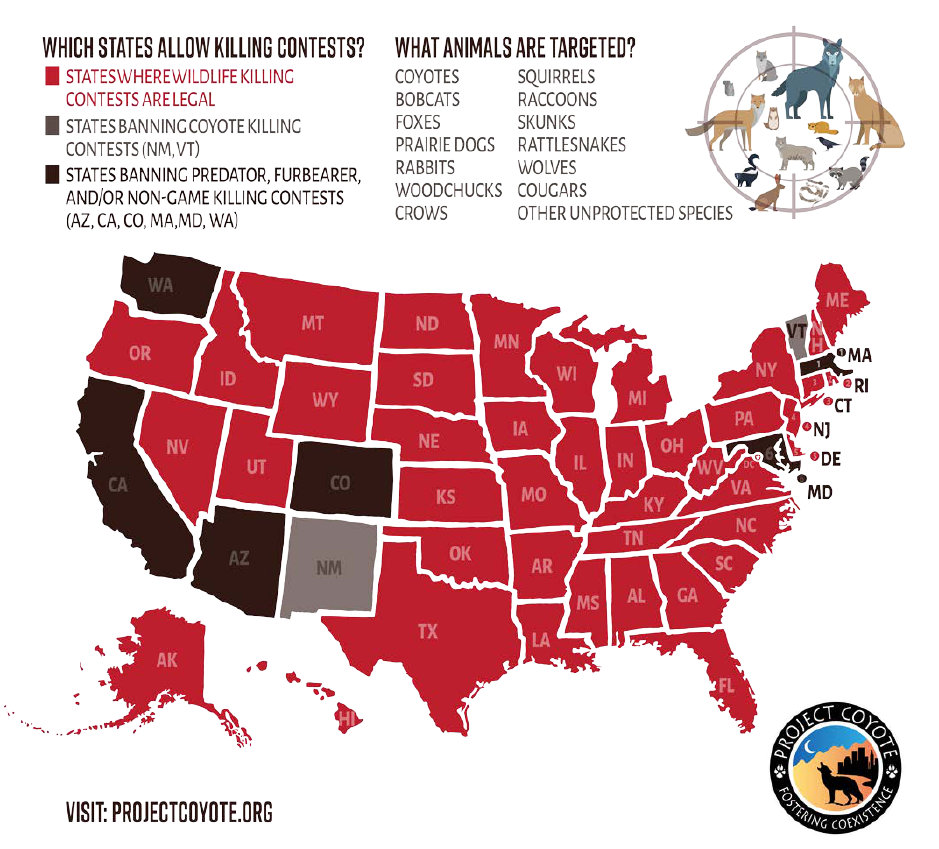
Figure 1. States Allowing Wildlife Killing Contests. Source: Project Coyote. http://www.projectcoyot e.org/endkillingcontests/ (accessed on 31 March